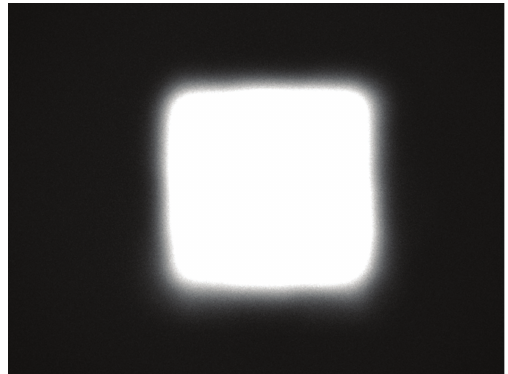
Figure 8: Concentration spot on the receiver.